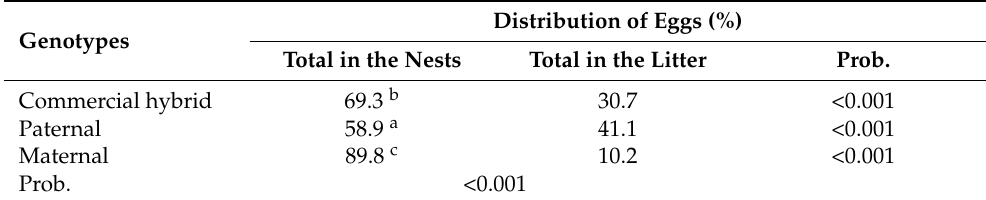
Table 1. The total ratios of the eggs laid in the nests and in the litter during the 12 months of production in percentages (%). Distribution of Eggs (%) Genotypes Total in the Nests Total in the Litter Prob. Commercial hybrid 69.3 b 30.7 <0.001 Paternal 58.9 a 41.1 <0.001 Maternal 89.8 c 10.2